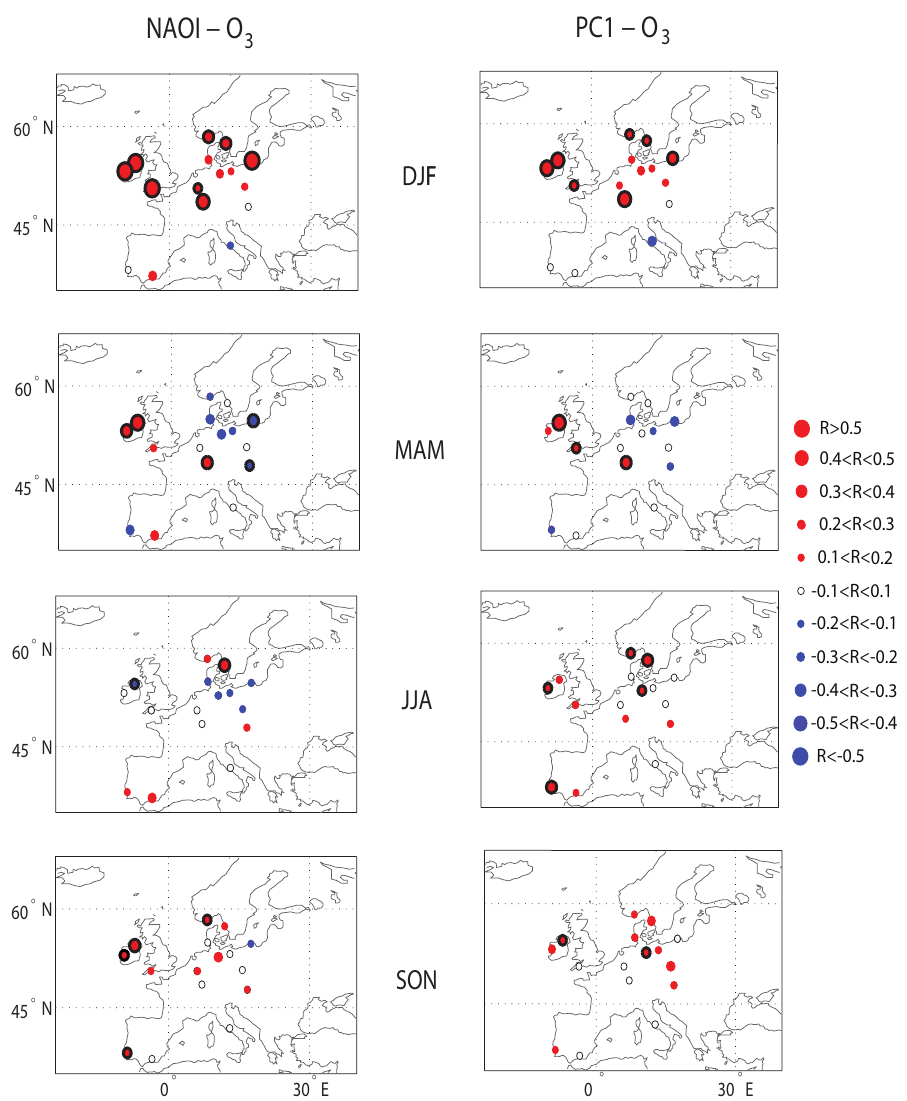
Fig. 4. Seasonal correlation calculated from monthly data between NAOI (left) and PC1 (right), and surface O 3 volume mixing ratios mea- sured at ground stations listed in Table 1. The correlation intervals are shown in the legend. Black bold rings indicate significant correlation with 90%